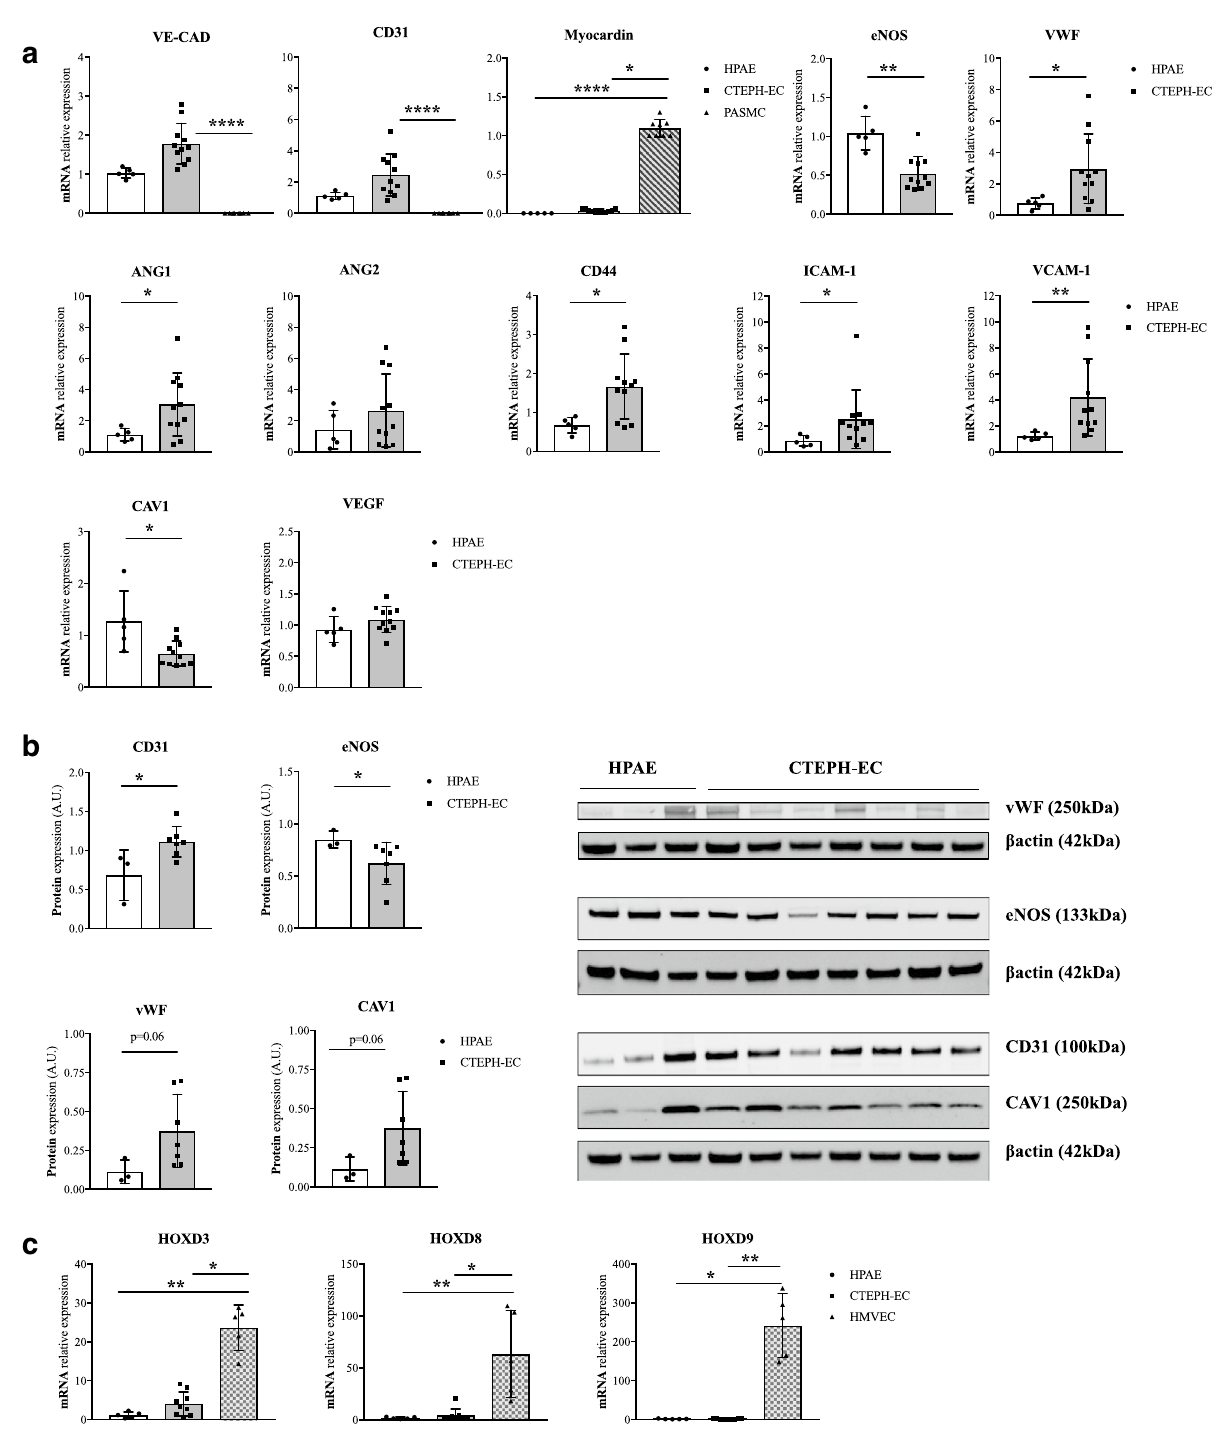
Figure 3. Expression of cell-specific markers in CTEPH-EC. ( a ) CTEPH-EC presented endothelial markers at the mRNA level and were negative for muscular markers (myocardin). Values expressed as mean ± SD, n = 5 HPAE, n = 11 CTEPH-EC and n = 8 SMC independent experiments performed in triplicate, p < 0.05*, p < 0.01**, p < 0.0001****, Mann–Whitney U test comparing two groups and Kruskal–Wallis test followed by Dunn’s multiple comparisons test for three groups. ( b ) CD31, eNOS, vWF and Cav-1 protein levels in CTEPH-EC compared to HPAE. Values expressed as mean ± SD, n = 3 HPAE, n = 7 CTEPH-EC independent experiments, p < 0.05*, Mann–Whitney U test, (full-length gels are presented in supplementary material Fig. 7). The intensity of the individual bands was quantified using freely available Image Lab software (Biorad laboratories), version 6.1.0 build7, http:// www. biorad. com. ( c ) CTEPH-EC and HPAE expression levels of HOXD3, -8 and -9 compared to HMVEC-L. Values expressed as mean ± SD, n = 5 HPAE, n = 9 CTEPH-EC and n = 5 HMVEC-L independent experiments performed in triplicate, p < 0.05*, p < 0.01**, Kruskal– Wallis test followed by Dunn’s multiple comparisons test. Statistical analysis was performed with GraphPad Prism 7 software, version 7.0e, serial number:GP7-0633739-R###-#####, https:// www. graph pad.